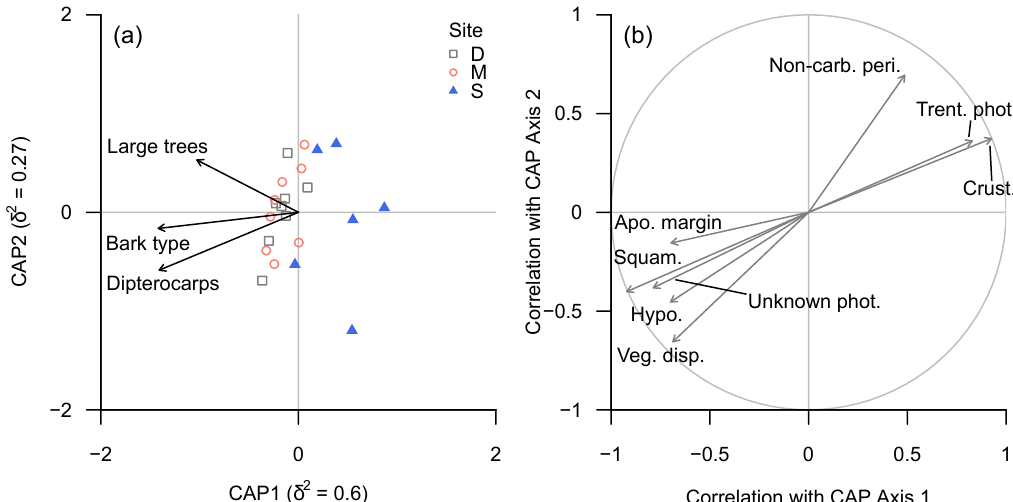
Figure 7. ( a ) CAP ordination plot of lichen functional trait composition according to continuous environmental (tree trait) variables, based on ‘plot-level’ data summarised for each plot. ( b ) Spearman rank correlation coefficients between CAP axes and individual functional groups for which | ρ | ≥ 0.6. Functional trait abbreviations: see Table